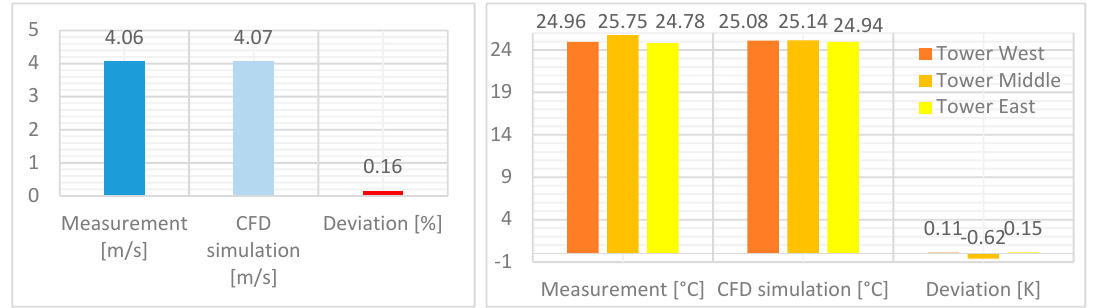
Figure 12. Measured and simulated wind velocity ( left ) and air temperature ( right ) comparison in the three ventilation towers.